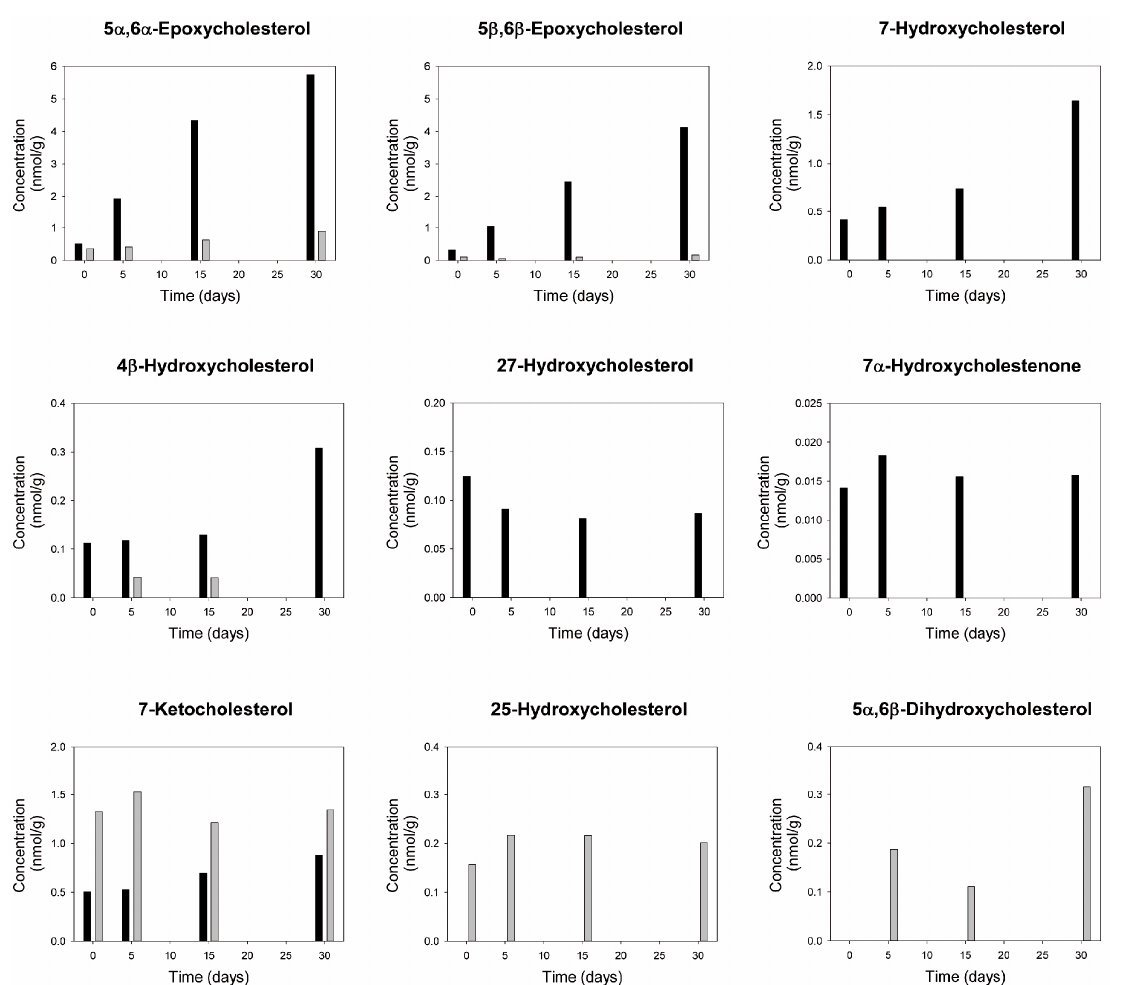
Figure 6. Temporal changes in oxysterols in hoki liver oil (black bars) and anchovy oil (gray bars) during the 30-day incubation under Condition A (exposure to oxygen and light at room temperature). Results are means ± S.D. of three technical replicates for one incubation.